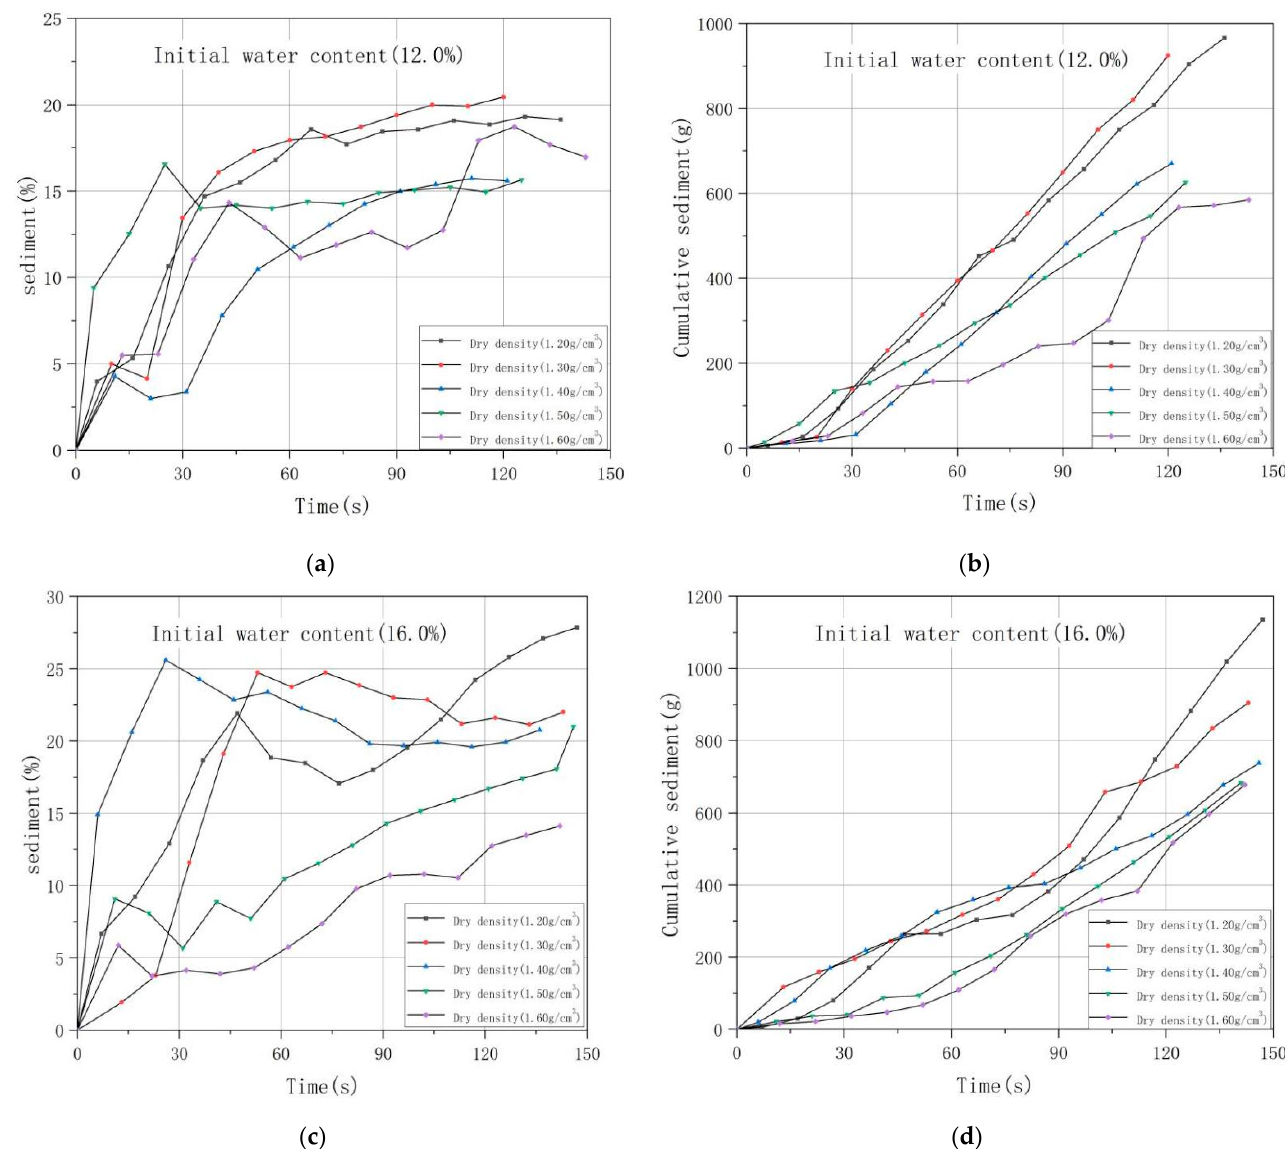
Figure 5. Curves of representative sediment discharge and cumulative curves of the representa-tive sediment discharge. Initial water content (12%) sediment ( a ); Initial water content (12%) cumulative sediment ( b ); Initial water content (16%) sediment ( c ); Initial water content (16%) cumulative sediment ( d ).